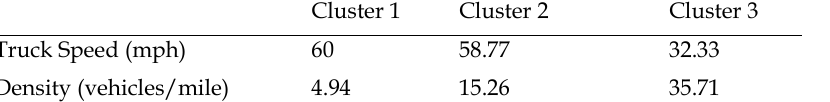
Figure 4. Case study I three clusters truck speed-density plot Table 4. Case Study I Cluster Centers of Three Clusters Analysis